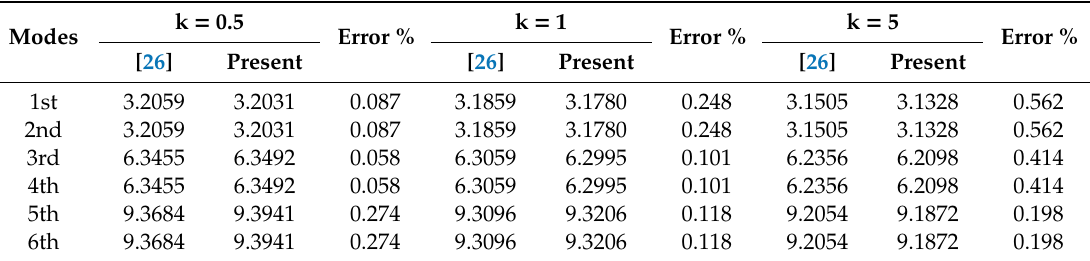
Table 2. Dimensionless natural frequencies of simply supported non-rotating FG shaft.